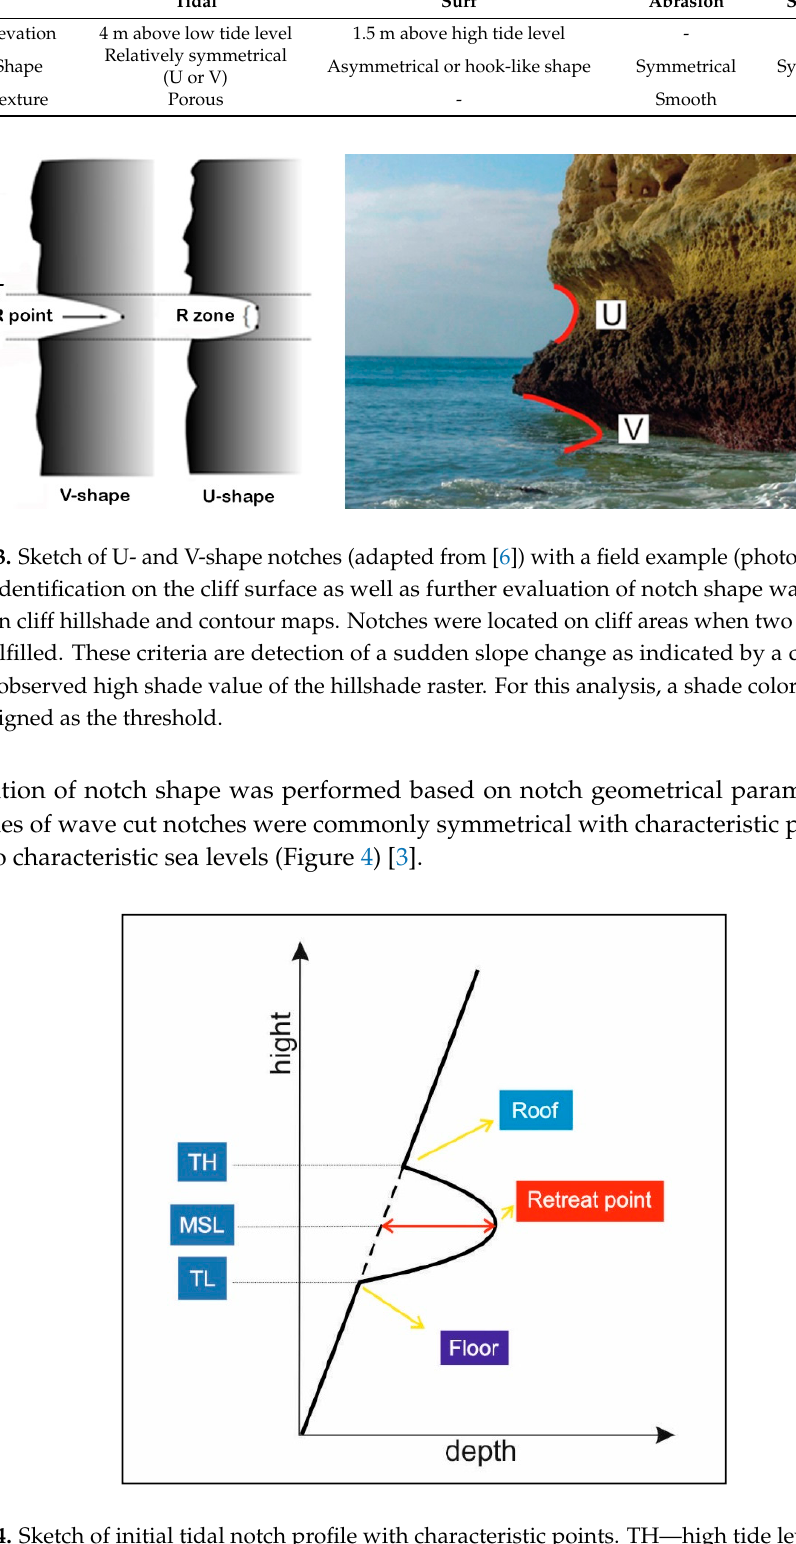
Figure 4. Sketch of initial tidal notch profile with characteristic points. TH—high tide level, TL—low tide level, MSL—mean sea level.